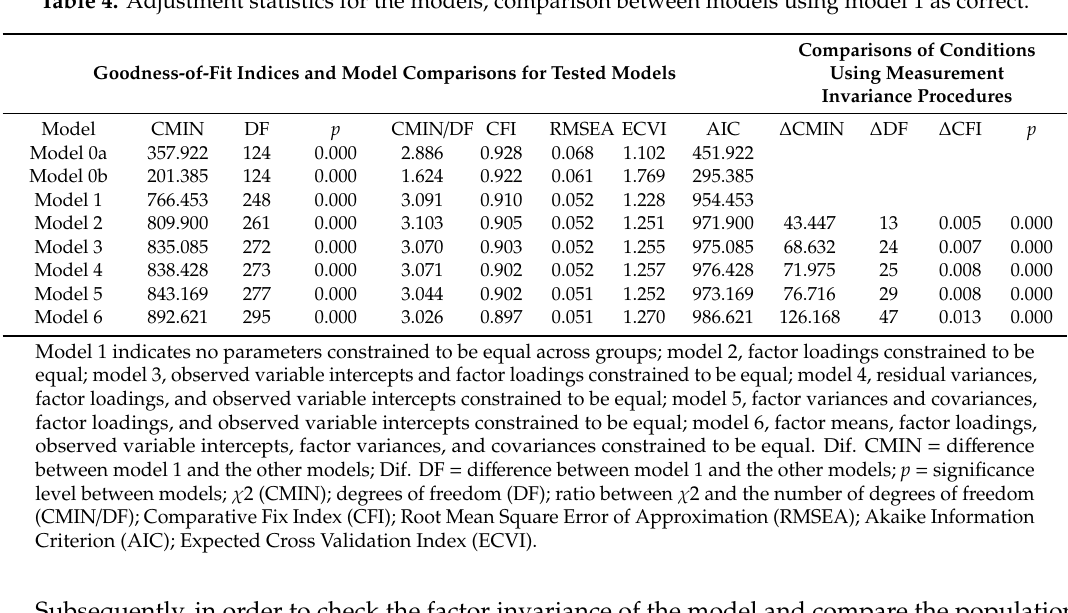
Table 4. Adjustment statistics for the models, comparison between models using model 1 as correct. Goodness-of-Fit Indices and Model Comparisons for Tested Models Model p Model